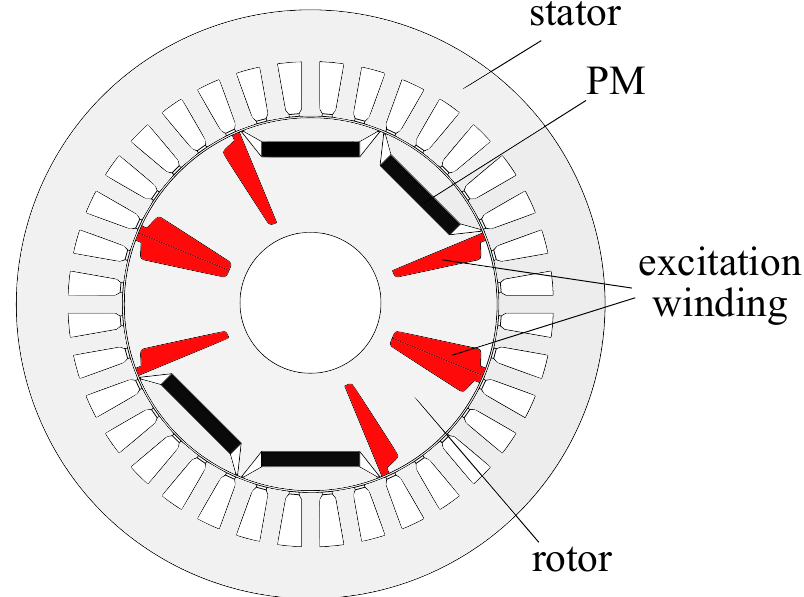
Figure 1. Sketch of the HEPM motor with interior